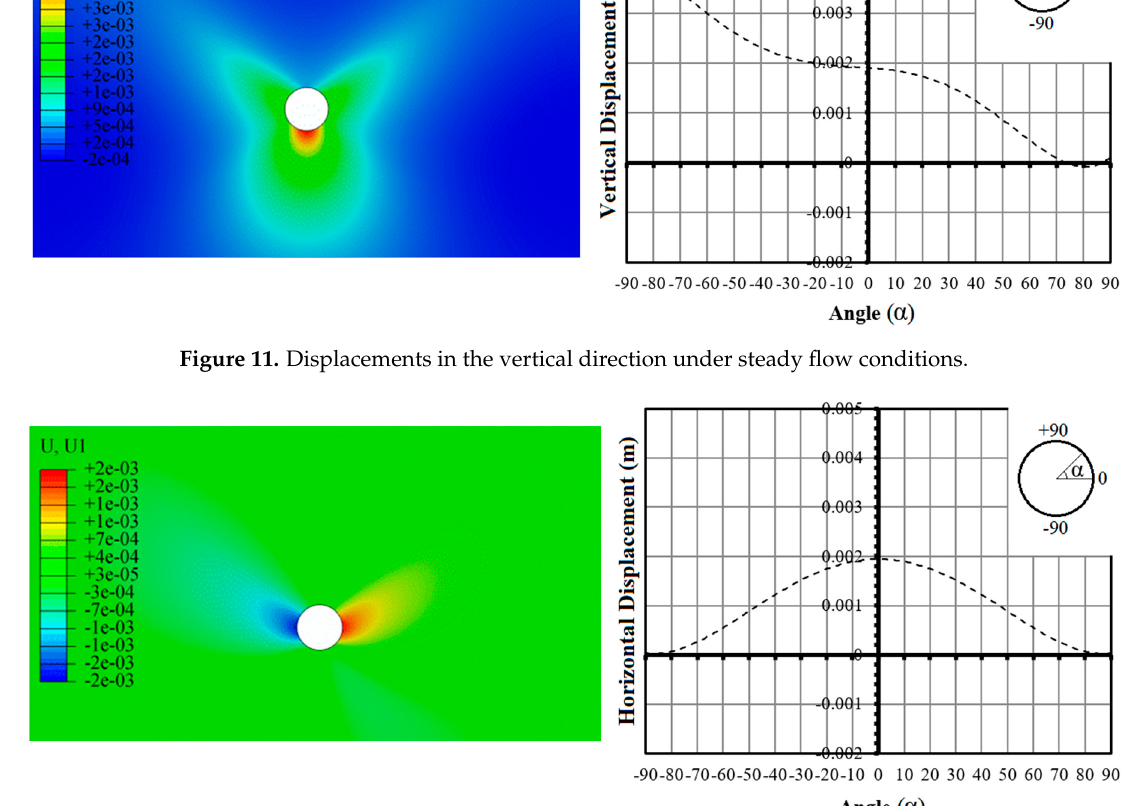
Figure 11. Displacements in the vertical direction under steady flow conditions.